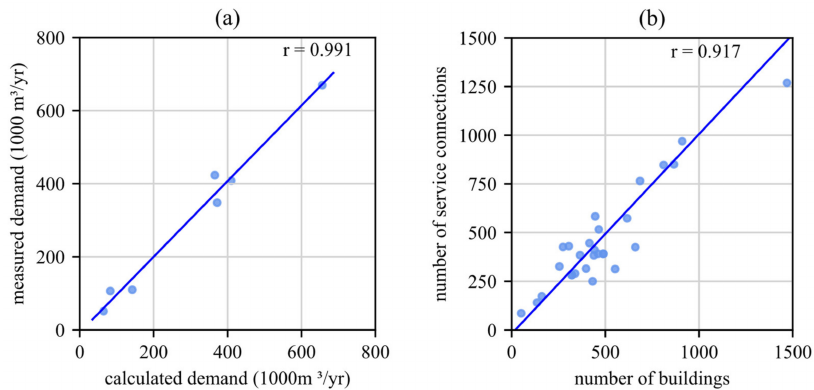
Figure 2. Correlation between ( a ) calculated water demand based on water assumptions per inhabitant and overnight stays and measured water demand as a total inflow reduced by estimated water losses and ( b ) number of service connections and number of